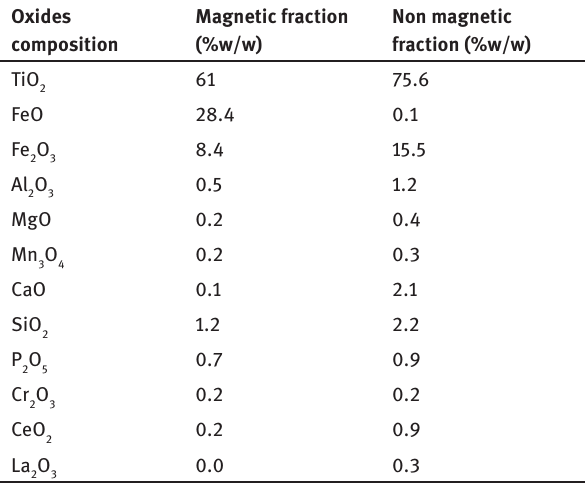
Table 1: Chemical compositions of the magnetic and non magnetic fractions of Bomar